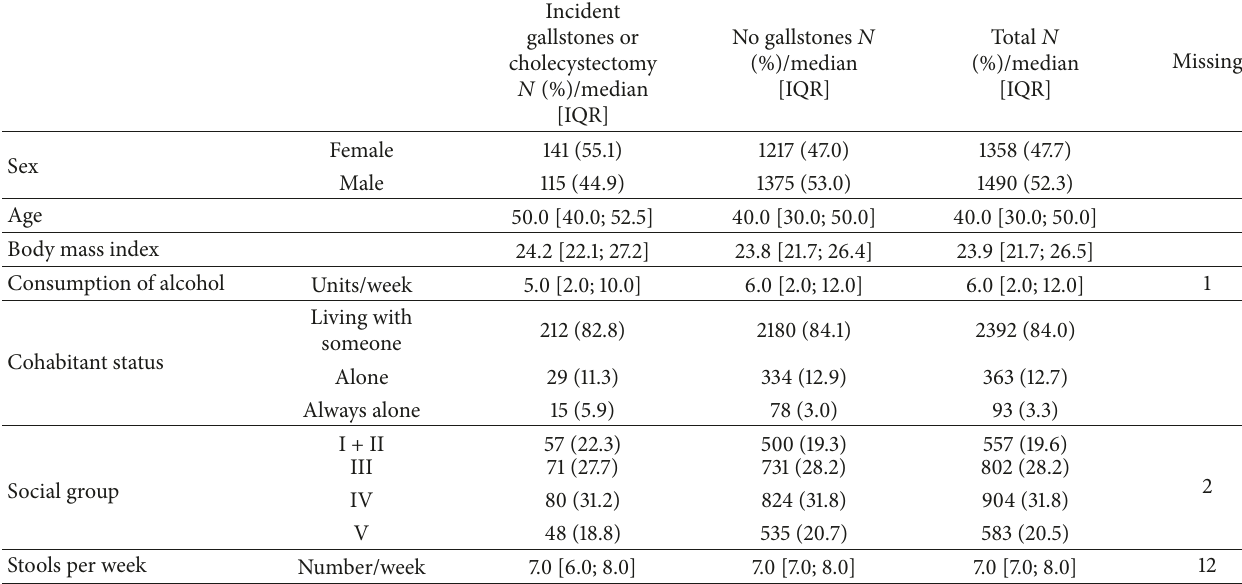
Table 1: Characteristics of study population at baseline,